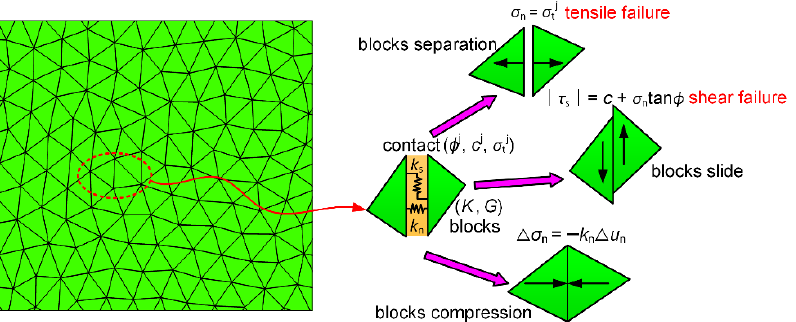
Figure 8. Constitutive behavior of contacts. ( K and G are the bulk and shear moduli of blocks. c j ; Φ j , and σ tj are the cohesion force, internal friction angle, and tensile strength of contacts. Δ σ n and Δ u n are the effective normal stress increment and normal displacement increment. σ n and τ s are the normal and shear stresses of contacts).